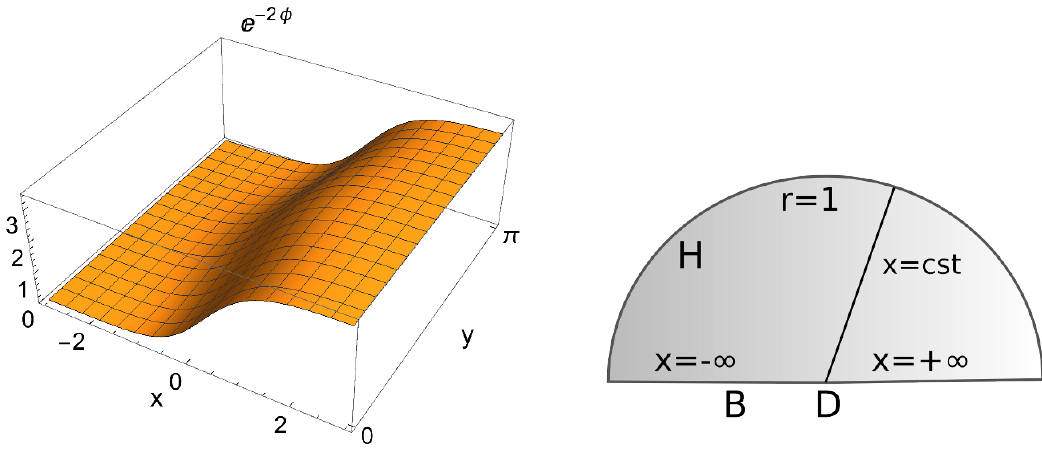
Figure 1 . Structure of the Janus solutions on the x - y plane and x - z plane. The Riemann surface (cid:6) is the in(cid:12)nite strip. For a solution supported only by RR (cid:13)uxes, the functions A; B and K have singularities on both boundaries at x = 0. The spacetime boundary B is reached for x ! (cid:6)1 and for z ! 0 on the AdS slice. The latter limit corresponds to the location of the defect D.